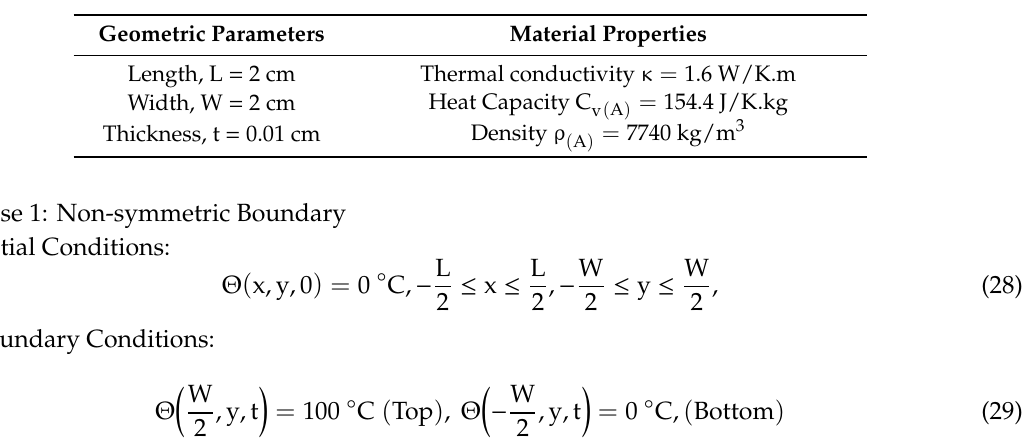
Table 2. Material properties and